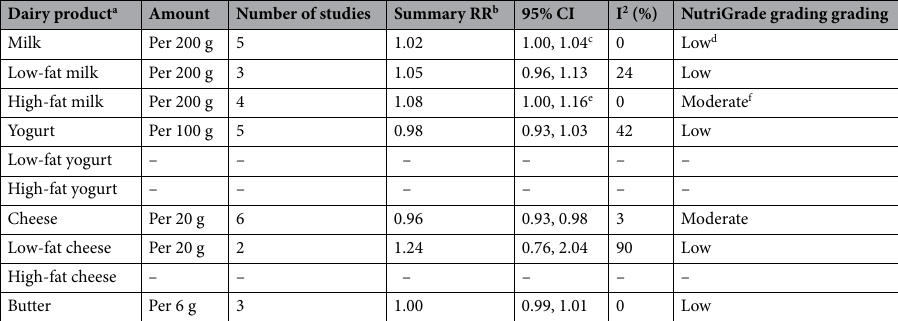
of CHD associated with a higher intake of high-fat milk. Results from dietary trials have shown that whole-fat milk increases total cholesterol and LDL-cholesterol more than low-fat milk such as skim milk 66 . However, the effects of whole-fat milk on HDL-cholesterol and the ratio of total cholesterol to HDL-cholesterol were less clear 66 . de Goede et al. 6 summarized findings of cohort studies on the association between intake of dairy products and risk of ischemic and hemorrhagic stroke aggregated in their systematic review from 2016. In subgroup